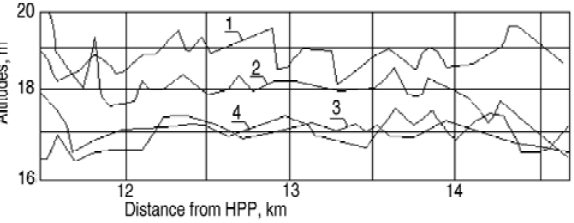
Fig. 1. Longitudinal profiles of the Nemunas